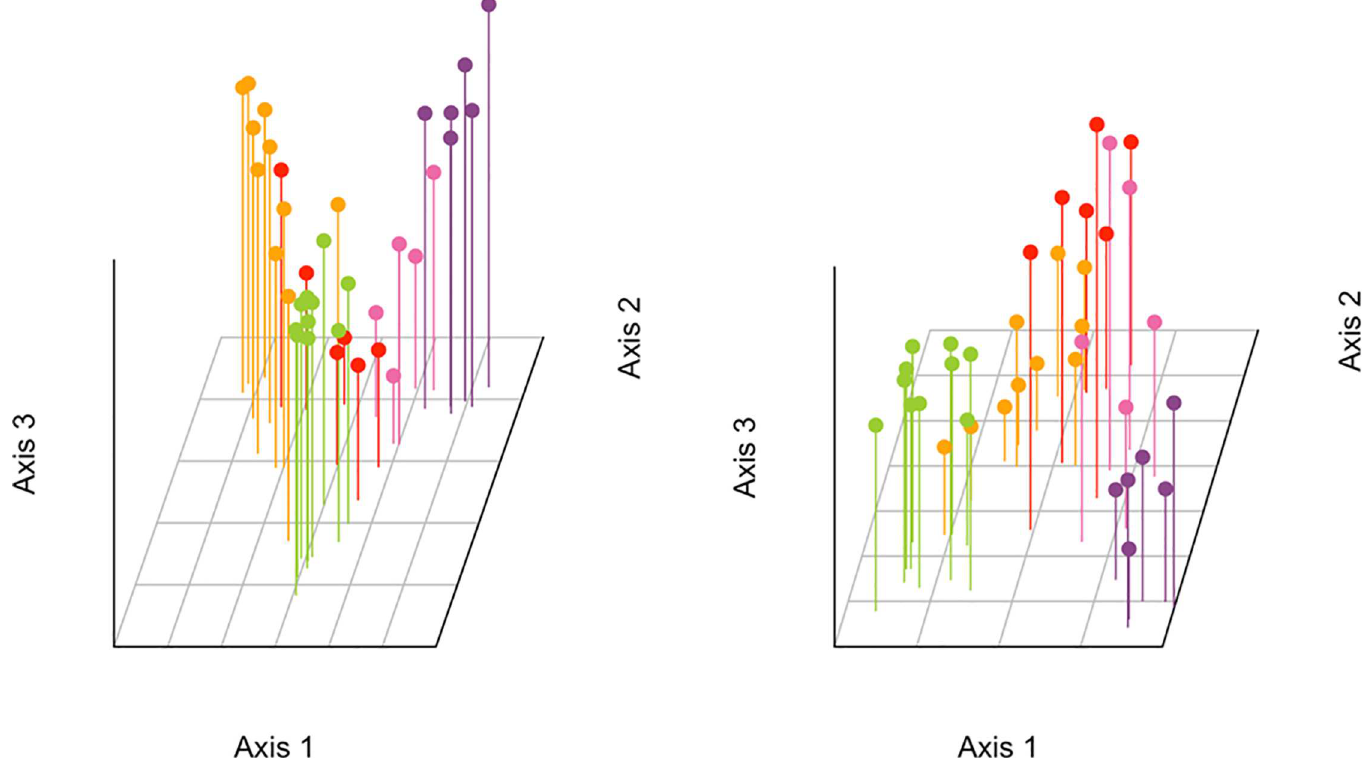
Fig 3. Three-dimensional plots using the first three eigenvalues of sPCA for the SNP (left) and microsatellite (right) datasets for the NOS to IBS subset. Values along axes 1, 2 and 3 represent lagged principal scores for each genotyperelative to the eigenvalue. Colors denote samplingsub-regions: NOS–purple, SK1 –pink, KB1 –red, BES2